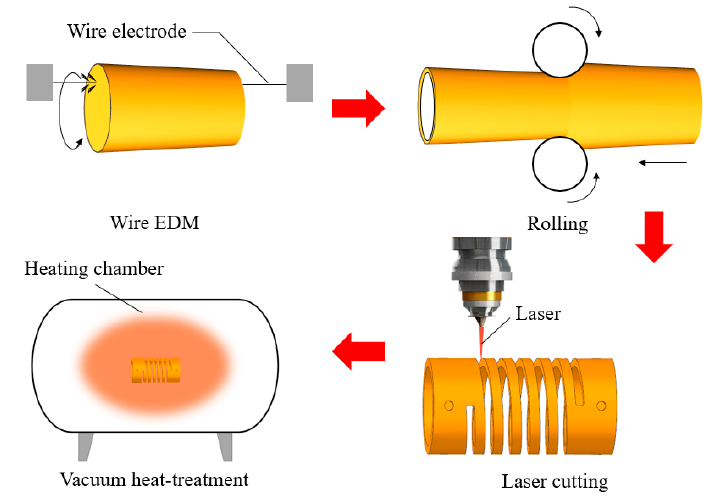
Figure 6. Fabricating process of the SMAMS.